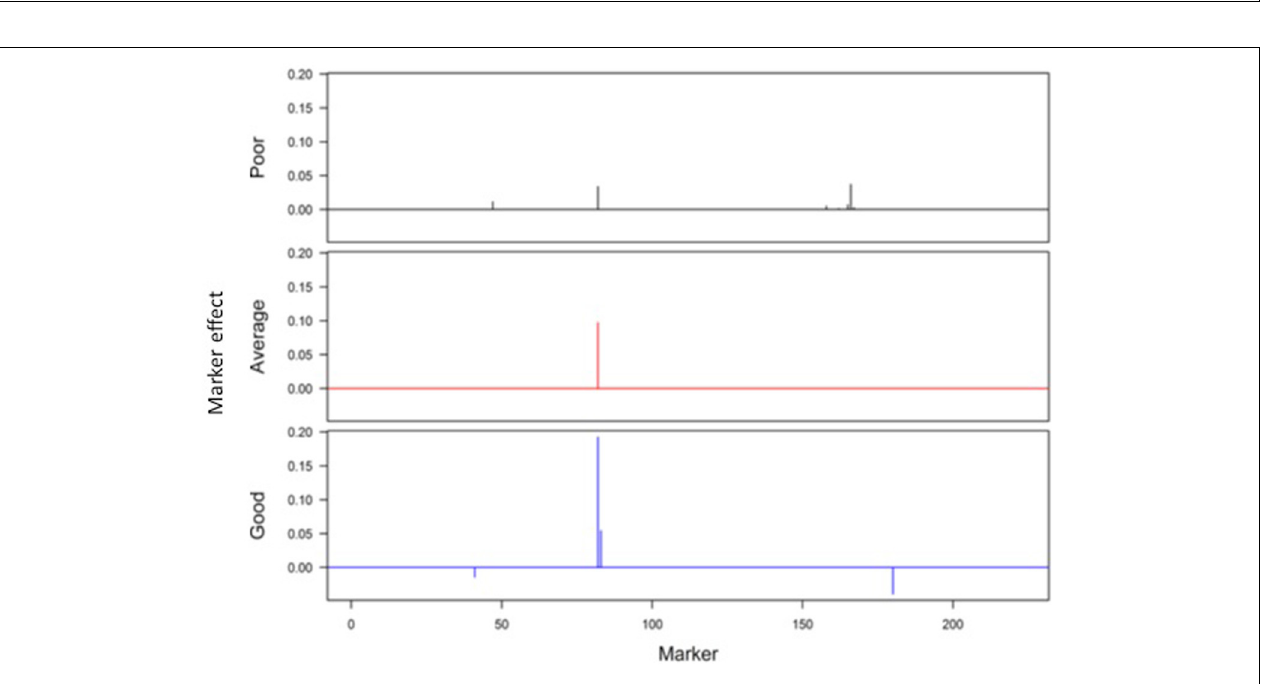
would have its own optimal growing environment. Any